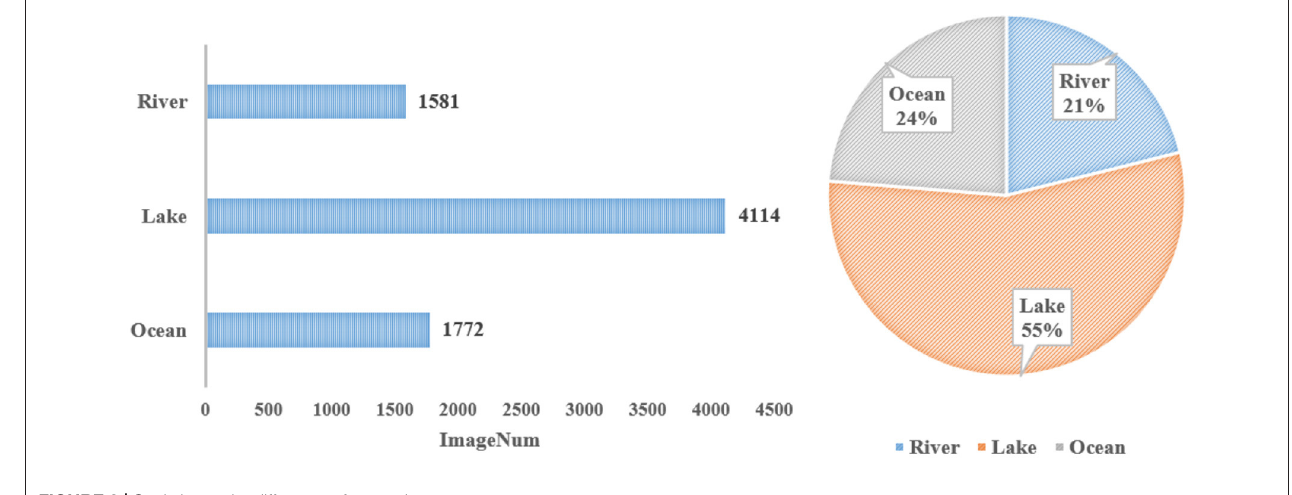
FIGURE 3 | Statistics under different surface environments.